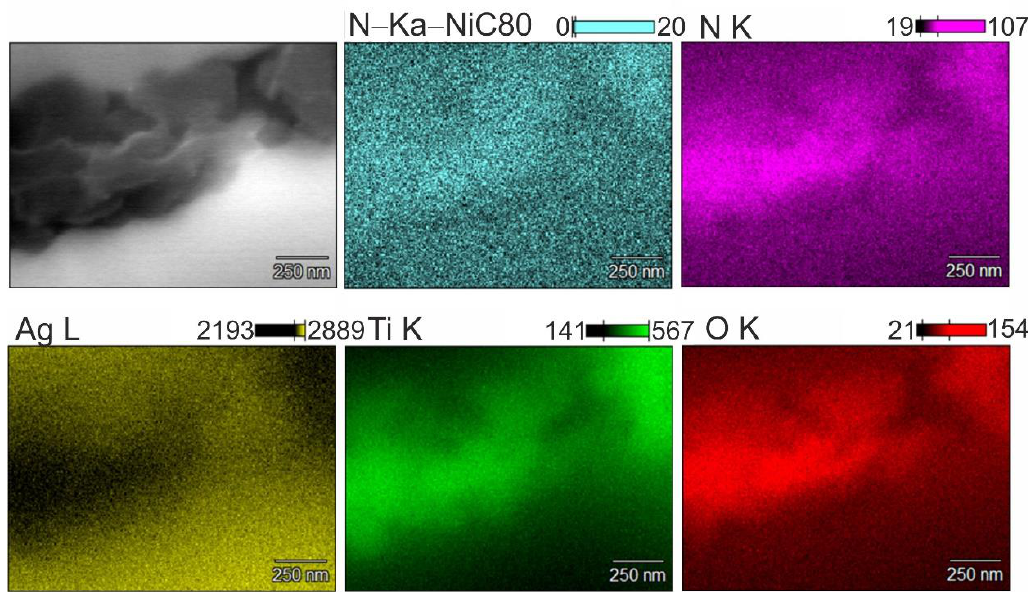
Figure 6. SEM and corresponding WDS mapping micrographs.